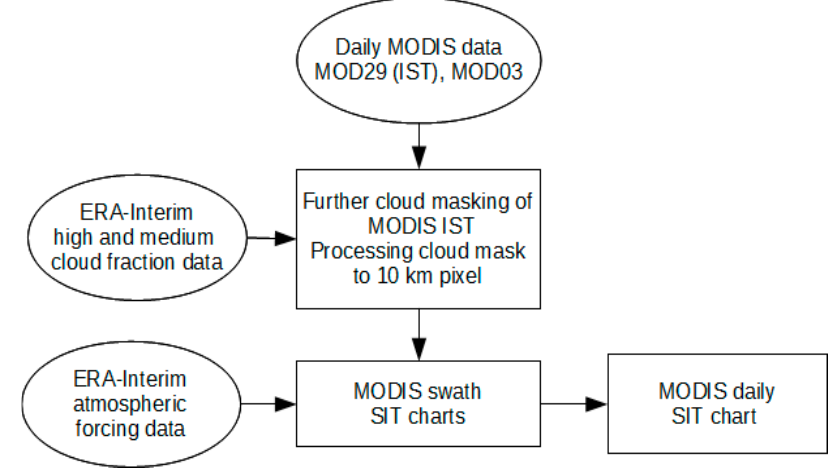
Figure 7. A general flowchart for the MODIS daily sea ice thickness chart processing.